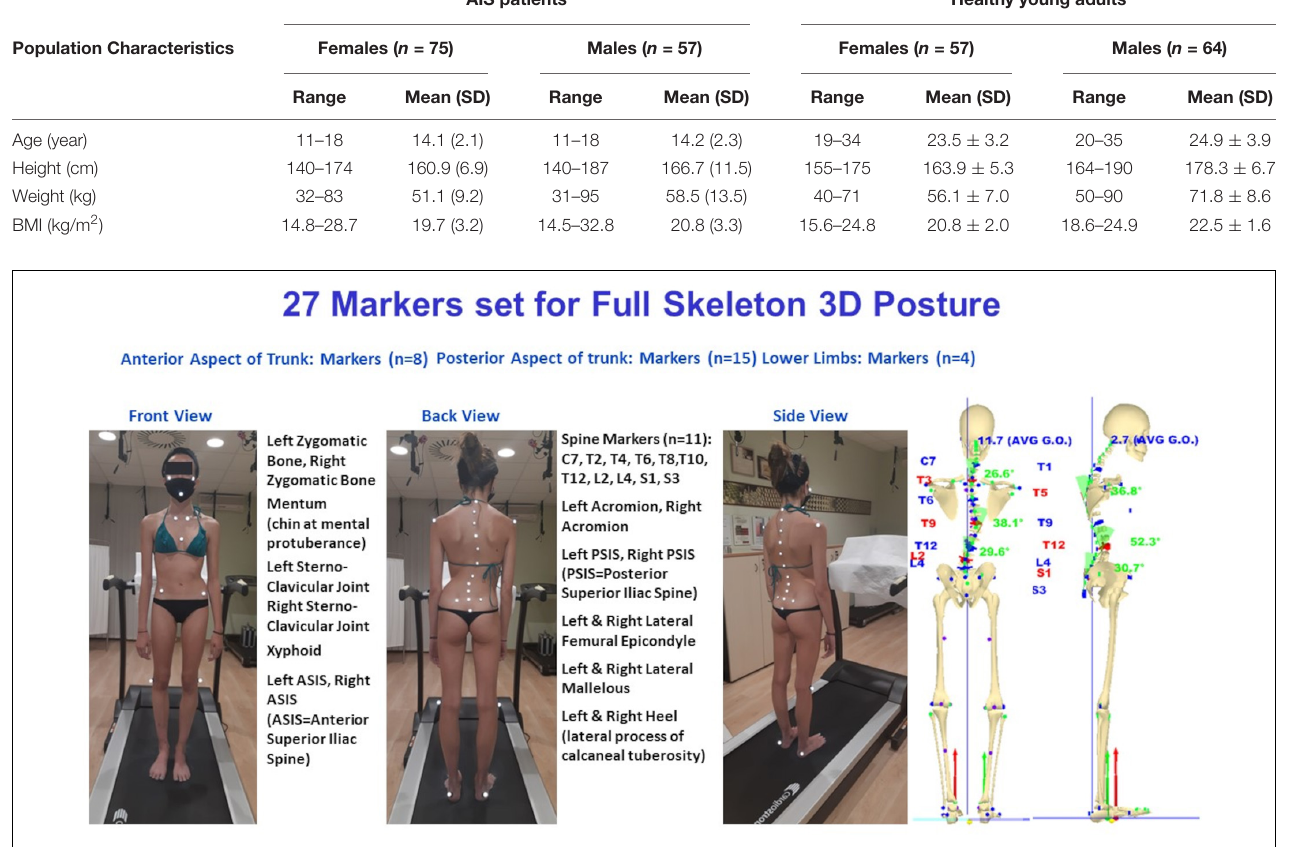
FIGURE 1 | The 27 markers set used for 3D posture analysis. The front and back view body landmarks labeled by markers are listed. Full skeleton reconstruction is included. Underfoot loads are represented by vertical forces vectors (red vector on the left side, green vector on the right